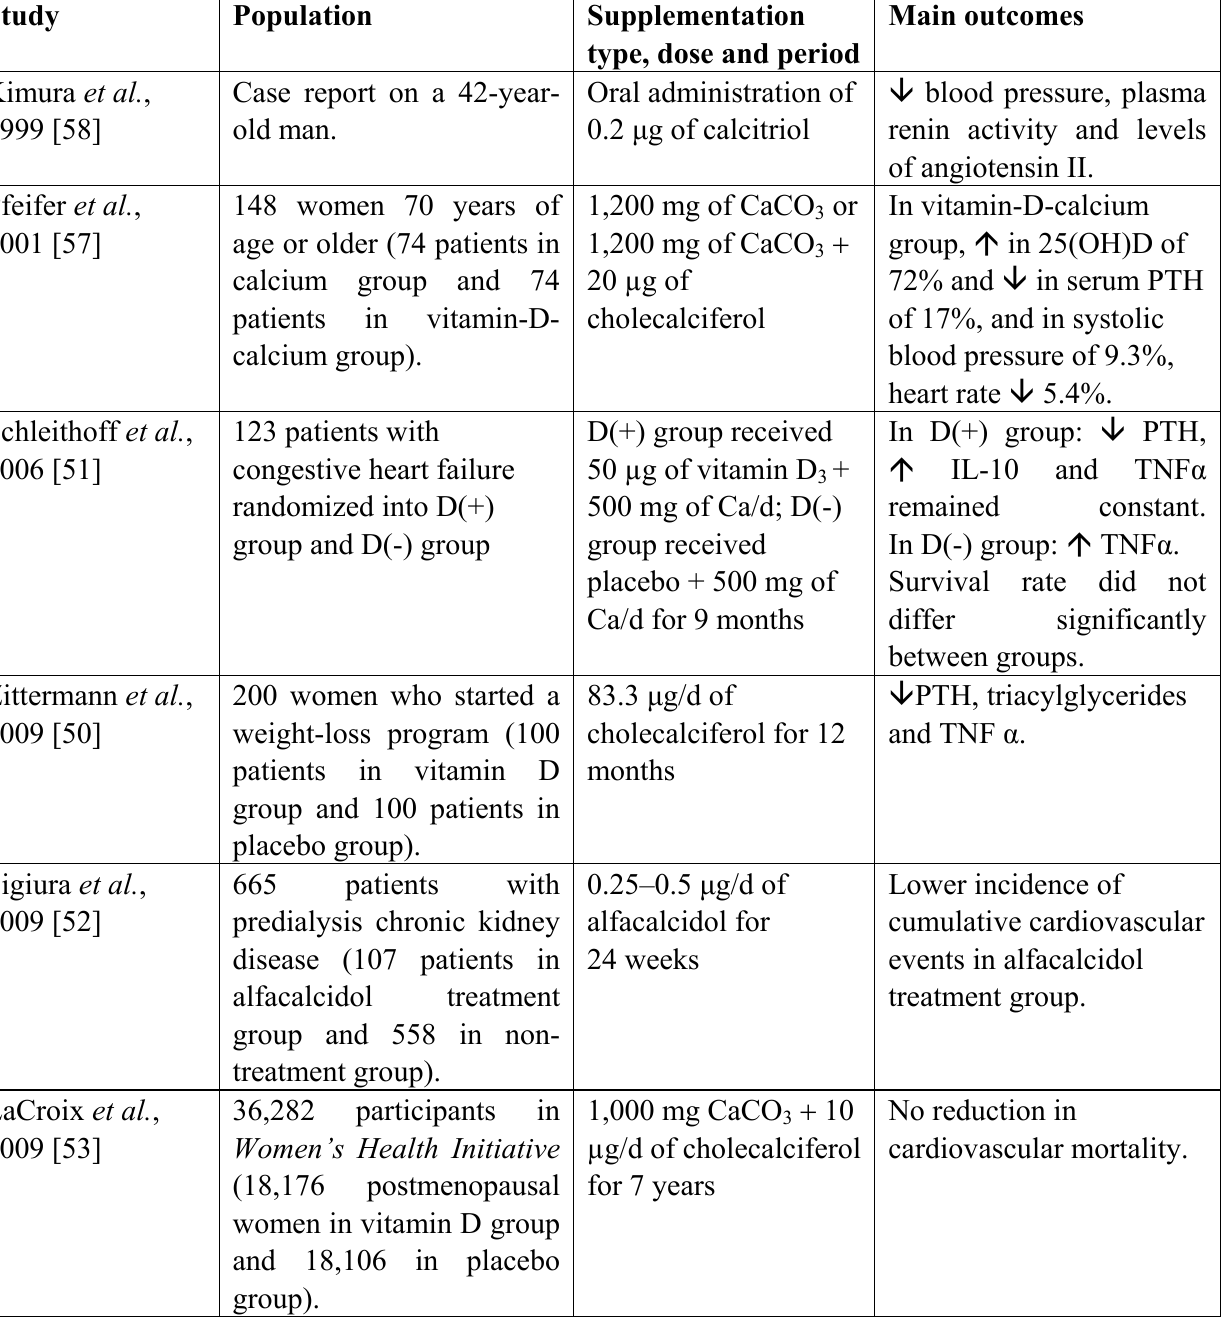
Table 2. Cardiovascular effects of vitamin D